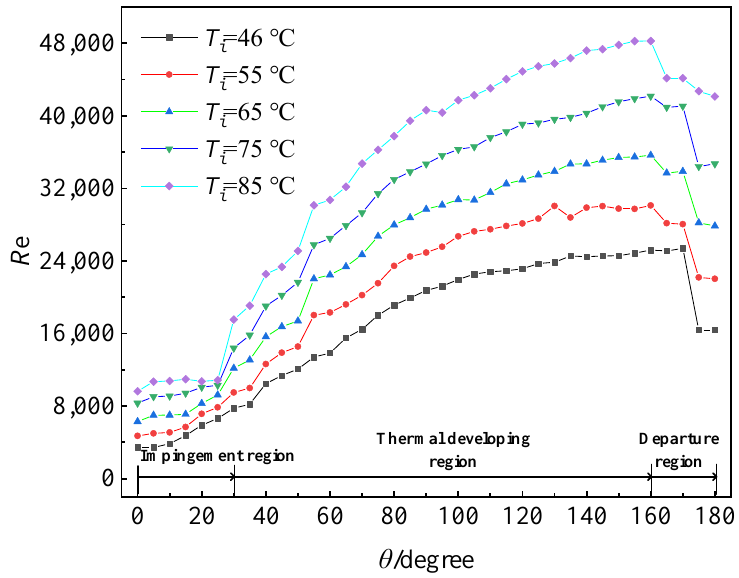
Figure 9. Local Reynolds number around tube under various spraying temperatures. The impact of the spraying temperature of the effluent on the local Nusselt number is shown in Figure 10. It can be seen that Nu θ grows with the growth of the spraying temperature. As the temperature grows, the viscosity of the fluid decreases, resulting in a decrease in the thickness of the liquid film and an increase in Nu θ . Heat transfer is also enhanced in terms of thermal conductivity because it increases with increasing temperature.